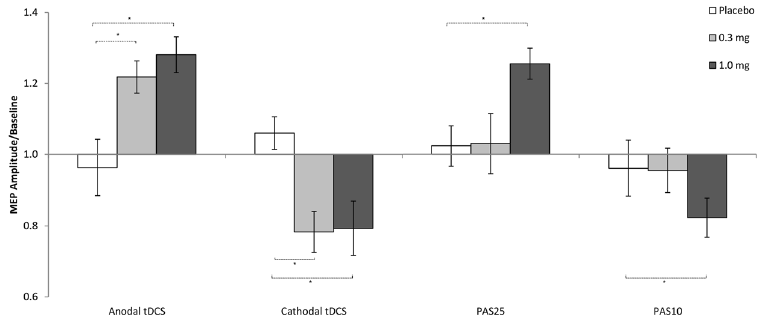
Figure 3. In smokers under placebo medication, tDCS- and PAS-induced plasticity is abolished. Furthermore, PAS also induced no excitability alterations under 0.3 mg varenicline. High dose varenicline restituted both tDCS and PAS-induced after-effects, while 0.3 mg varenicline only restored tDCS-induced plasticity. Each column represents the mean of baseline-normalized MEP ± S.E.M. amplitudes until 30 minutes after stimulation; Asterisks indicate significant differences between drug and placebo conditions (Student’s t-test, two tailed, paired samples, p <